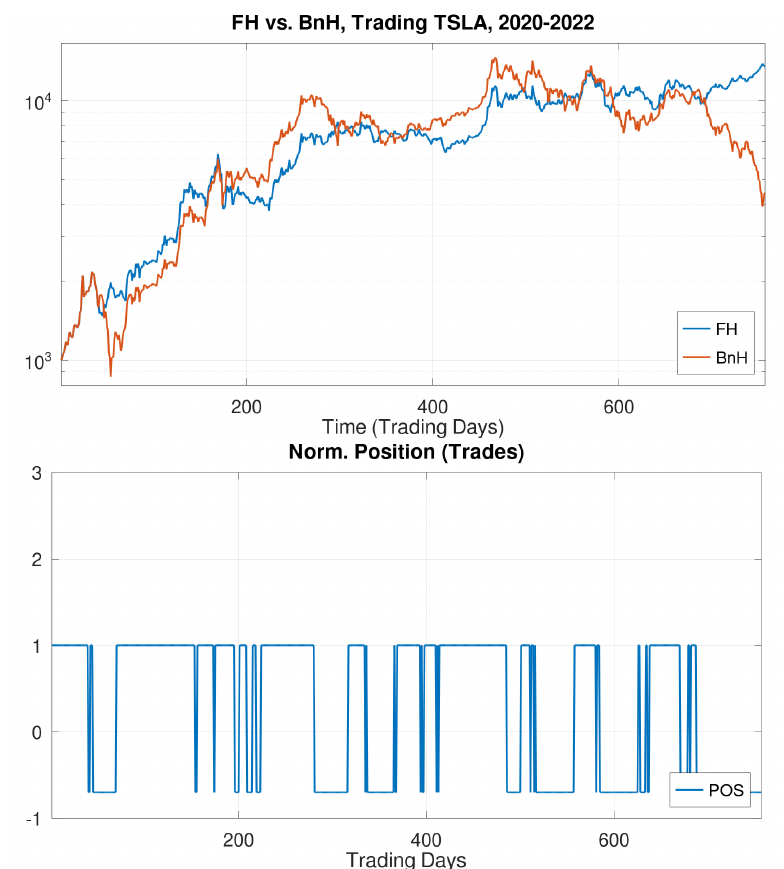
Figure 8. Performance of a FastHedge trading strategy for TSLA stock in the 3-year period 2020–2023, including portfolio gains as well as the trades